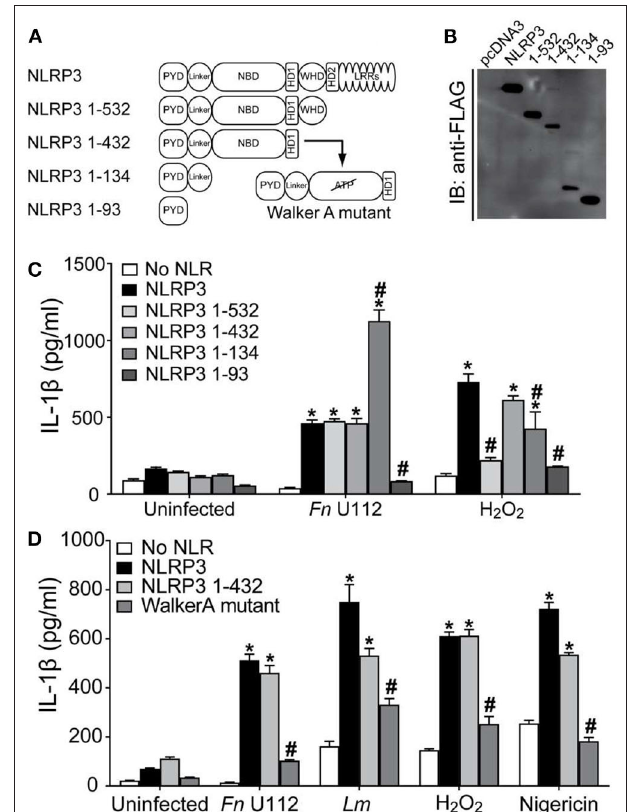
FIGURE 3 | NLRP3 1-134 is minimally required for agonist specific inflammasome activation. (A) Schematic representation of NBD mutants. (B) Representative western blot of FLAG-tagged NLRP3 and NBD mutants from HEK293T cell lysate. 10 µ g total protein was loaded in each well. EV-Empty vector. (C) IL-1 β response of HEK293T cells expressing ASC, pro-Caspase-1, pro-IL-1 β , and NLRP3, or the indicated truncation mutants. At 4-h post-transfection, cells were infected with Fn U112 (MOI 100) or 18–20h post-transfection, cells were treated 100 µ M H 2 O 2 (1h). (D) IL-1 β response of HEK293T cells expressing ASC, pro-Caspase-1, pro-IL-1 β , and NLRP3, or the indicated NBD mutants. For Fn U112 and H2O2, cells were treated as in (C)